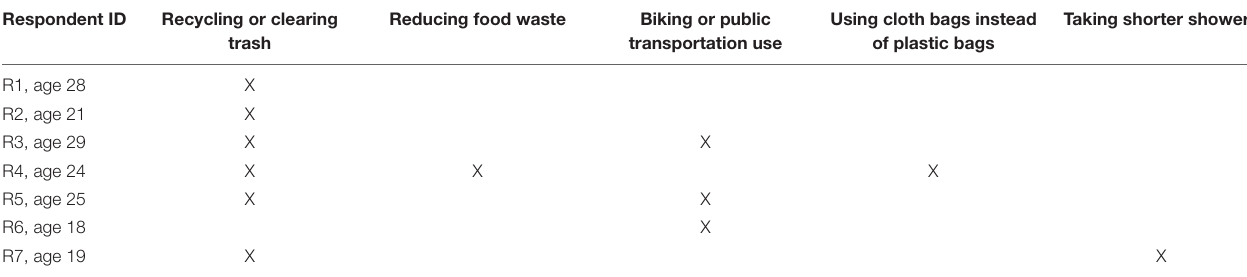
TABLE 1 | Active pro-environmental actions performed by the